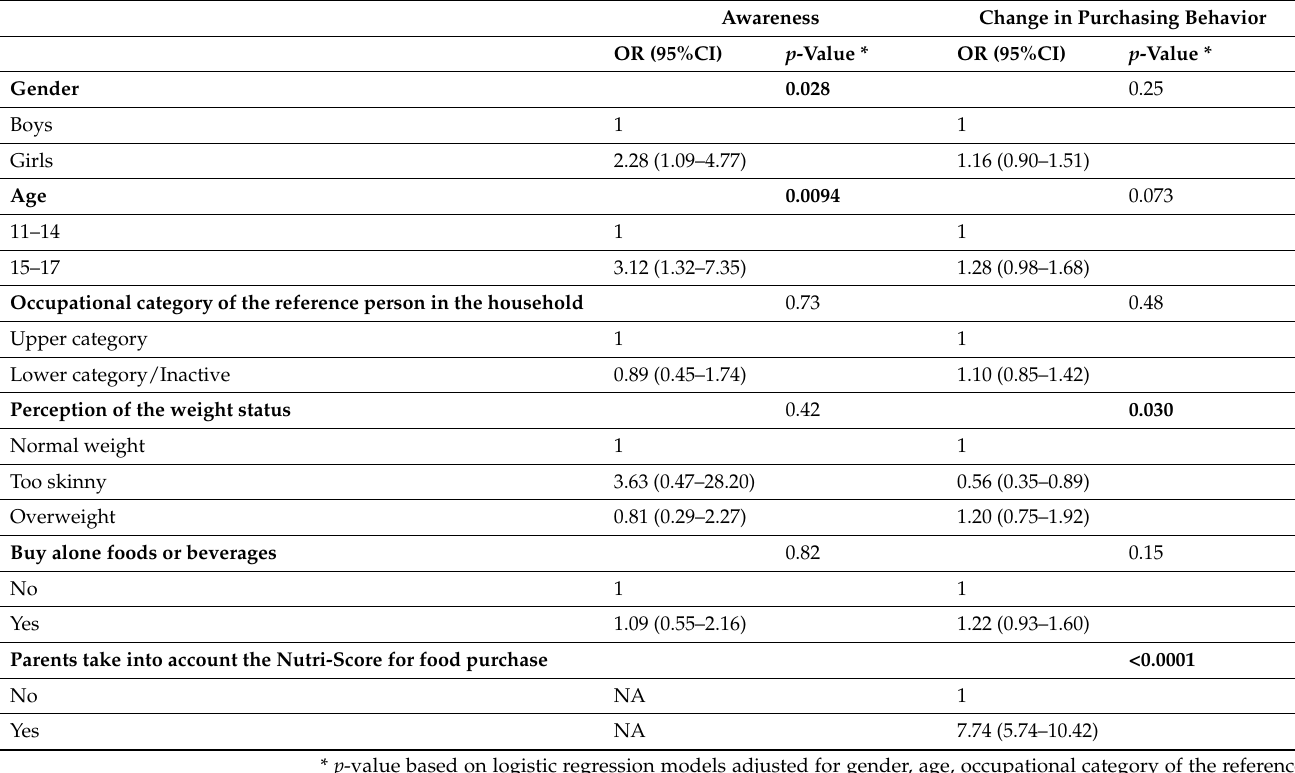
Table 4. Associations of Nutri-Score awareness (model 1) and change in purchasing behavior (model 2) with individual characteristics, based on logistic regression model ( n =